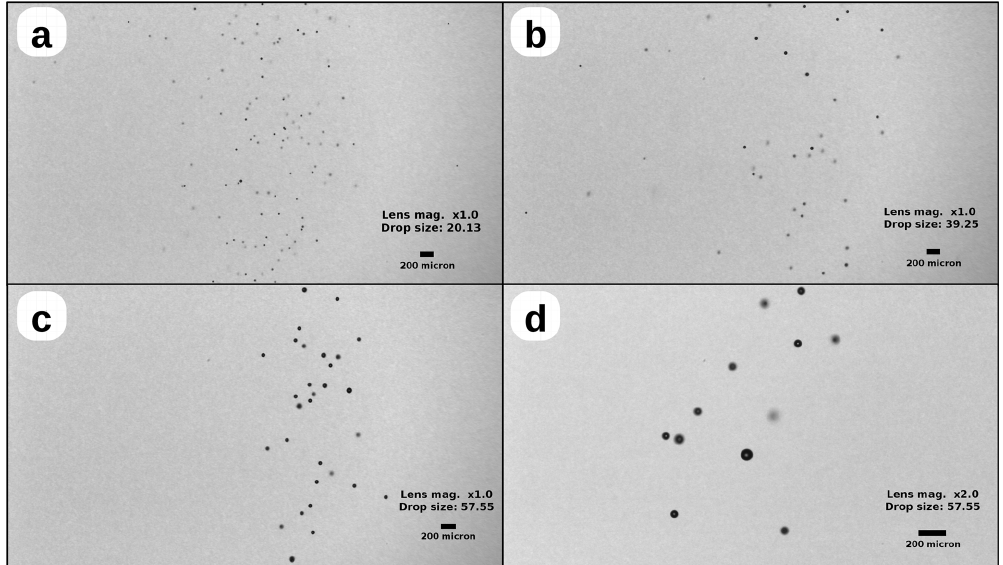
Figure 11. Sample shadow images captured by the VisiSize D30, showing droplets with different sizes that were generated by the FMAG.